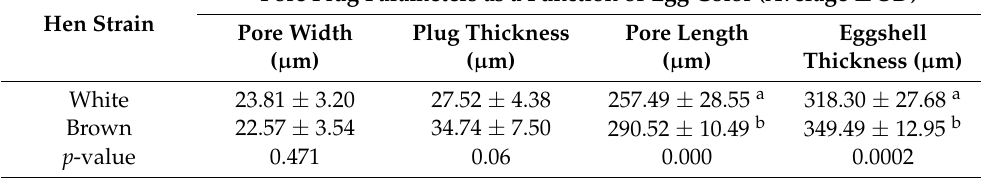
Table 1. Comparison of the pore plug parameters in unwashed eggs of different colors: white and brown from hens at mid-lay. Pore Plug Parameters as a Function of Egg Color (Average ± SD) Hen Strain Pore Width Plug Thickness Pore Length Eggshell ( µ m) ( µ m) ( µ m) Thickness ( µ m) White 23.81 ± 3.20 27.52 ± 4.38 257.49 ± 28.55 a 318.30 ± 27.68 a Brown 22.57 ± 3.54 34.74 ± 7.50 290.52 ± 10.49 b 349.49 ± 12.95 b p -value 0.471 0.06 0.000